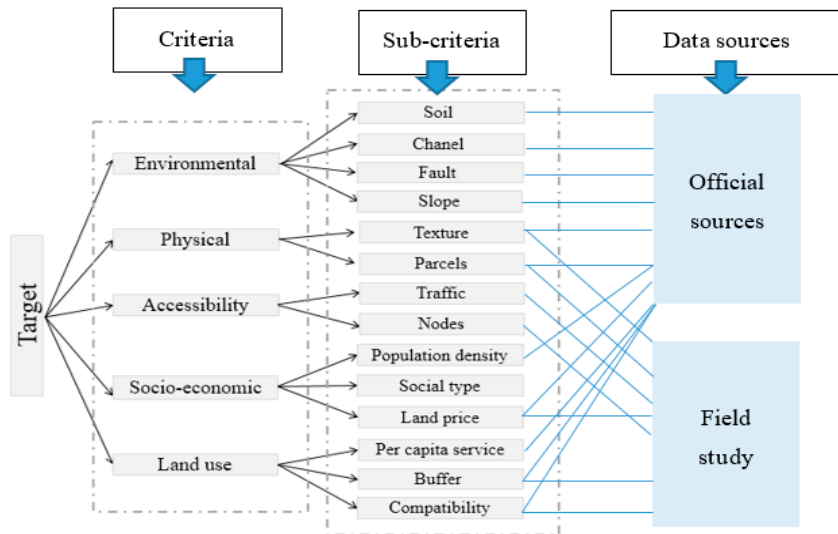
Figure 1. The structure of the criteria study including criteria (environmental, physical, accessibility, socio-economic, and land use), sub-criteria (soil, channel, fault, slope, texture, parcels, traffic, nodes, population density, social type, land price, per capita service, buffer, and compatibility), and data sources.